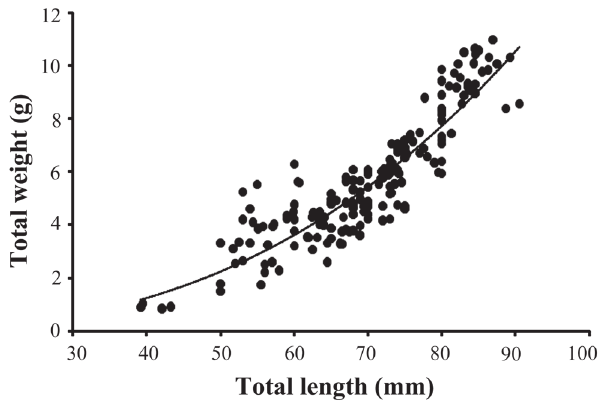
Fig. 8. Size at maturity (TL ) of Discopyge tschudii . Males 50% (  ): TL (continuous line): 30cm; R 2 = 0.98; n= 506. Females 50% ( o ): TL (dotted line): 21cm; R 2 = 0.98; n= 419. 50%